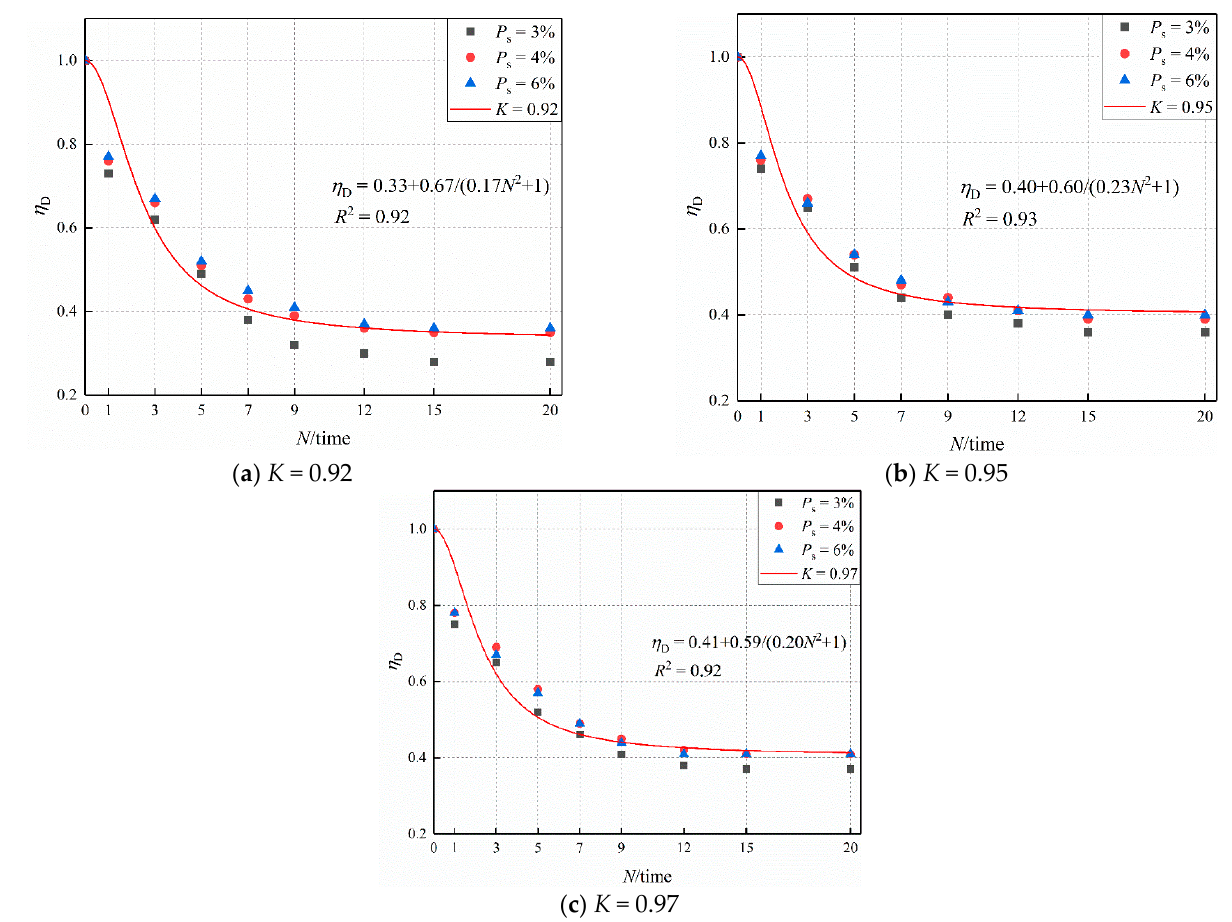
Figure 3. The relationship between η